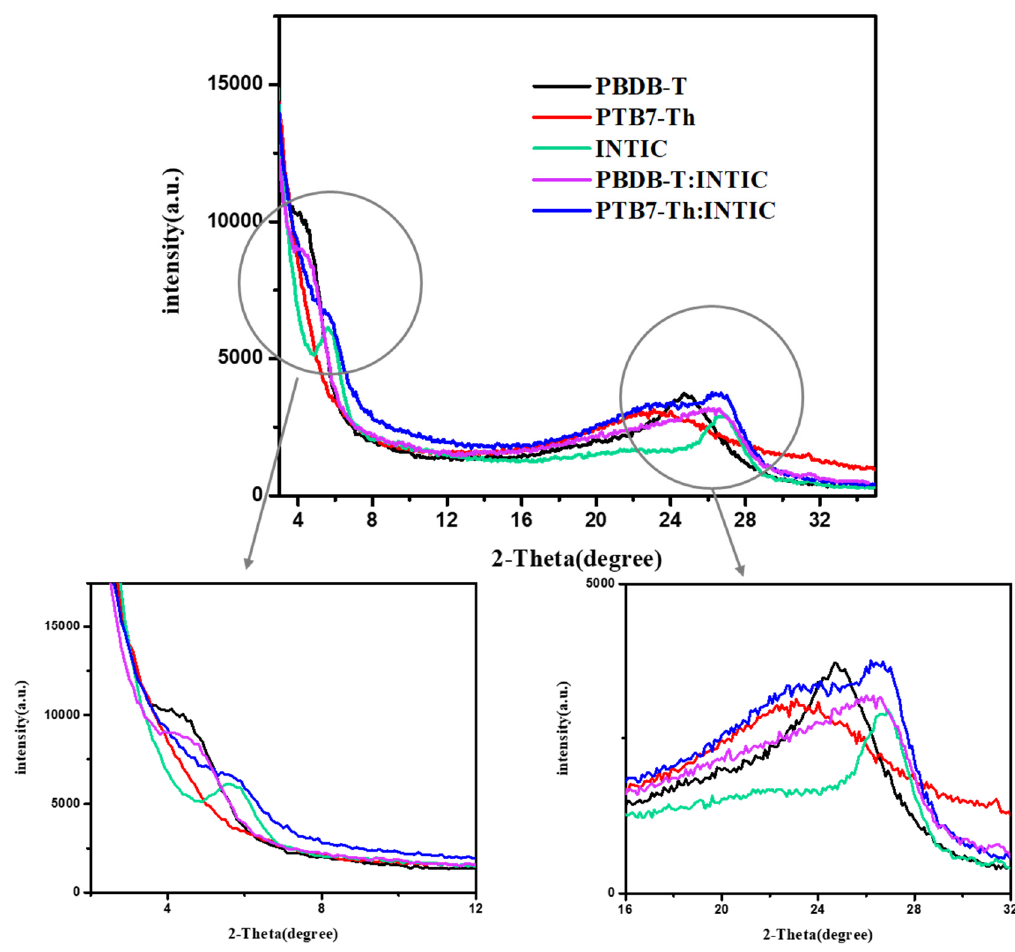
Figure 5. One-dimensional out-of-plane GIXRD of PTB7-Th, PBDB-T, INTIC pure film and PTB7-Th:INTIC, PBDB-T:INTIC mixed film.